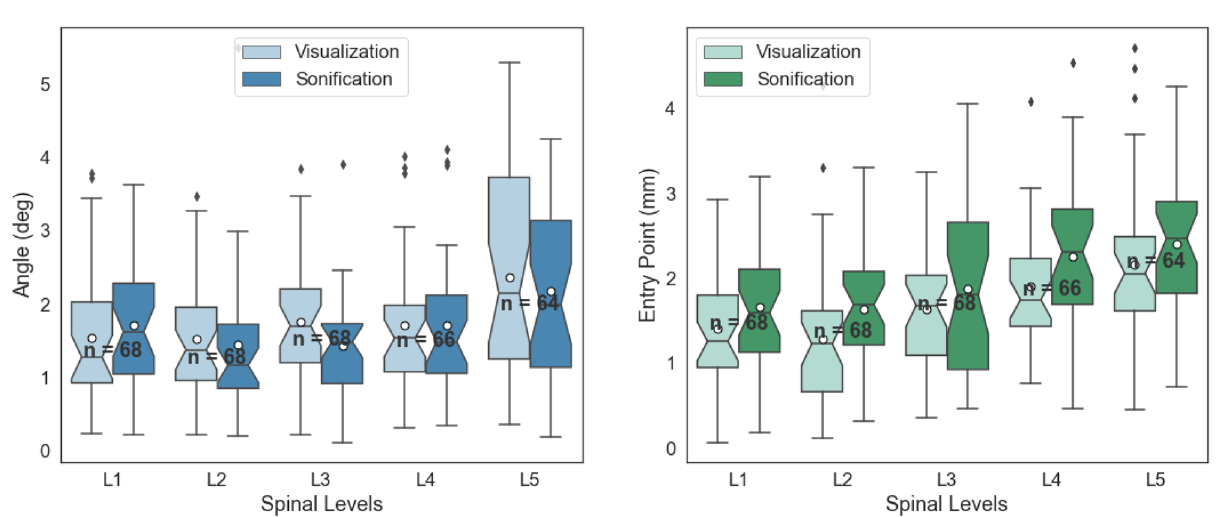
Figure 6. The mean (CT) error of angle on the left and entry point on the right, per spinal levels. The white dots in the middle of box plots represent the